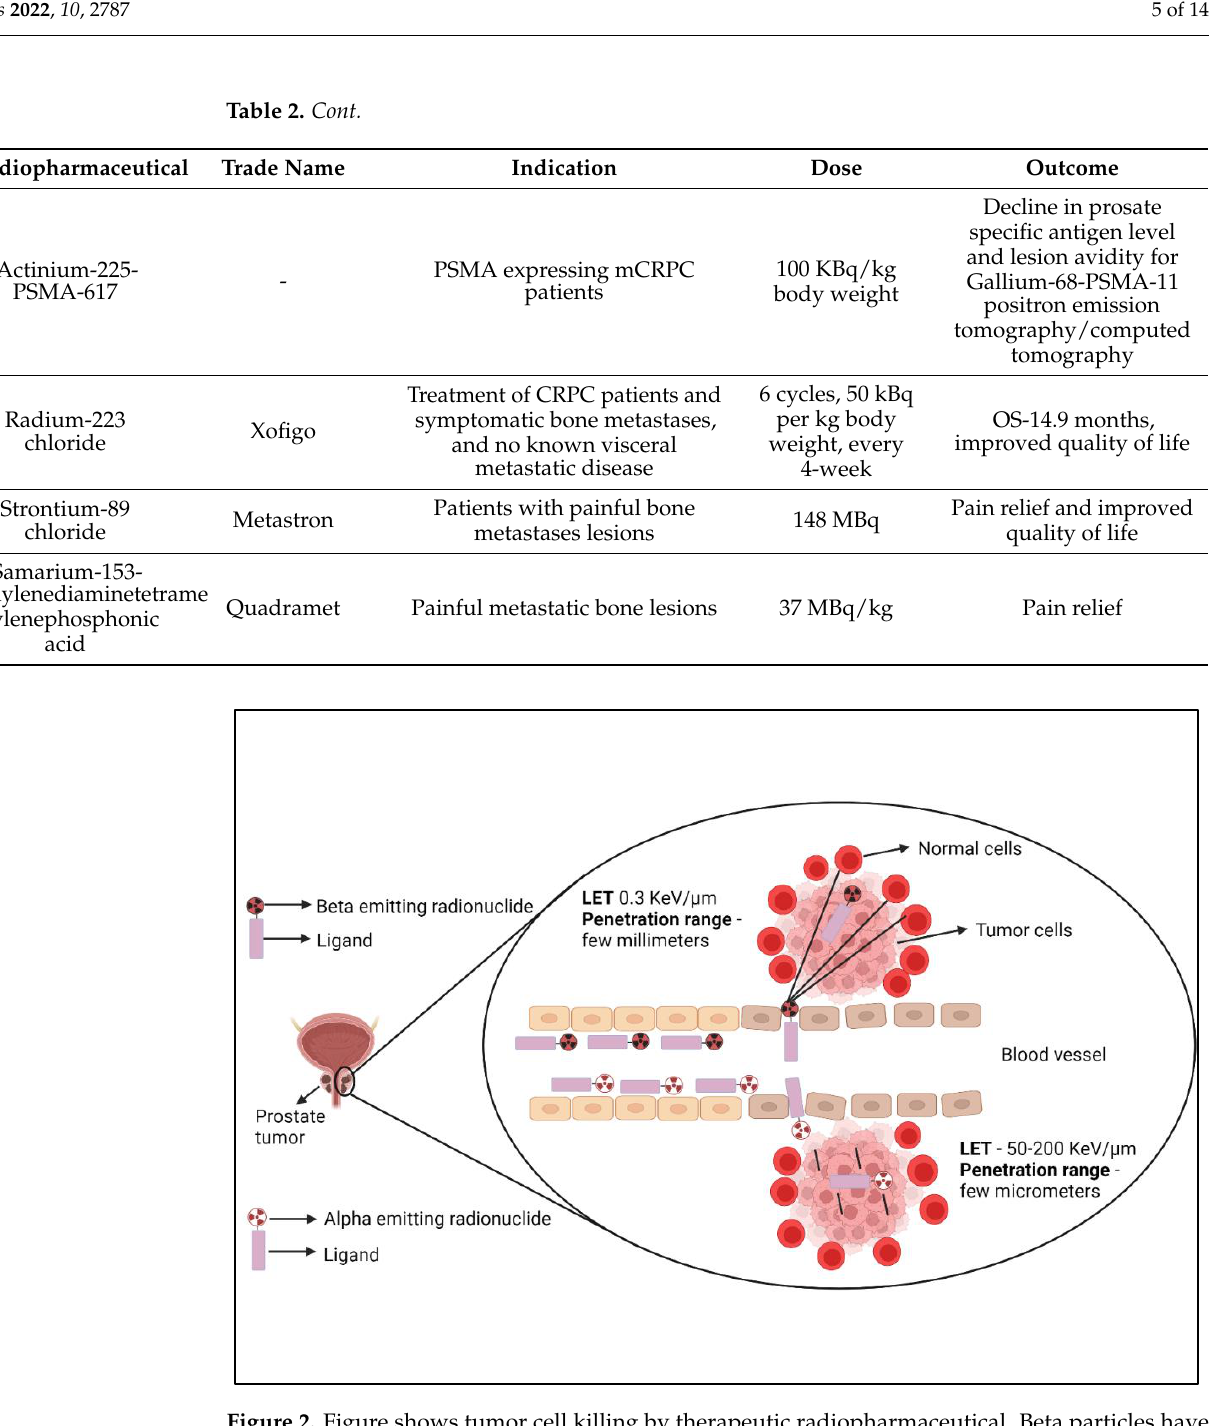
Table 2. Clinical utility and activity of therapeutic radiopharmaceuticals for prostate cancer and bone metastases